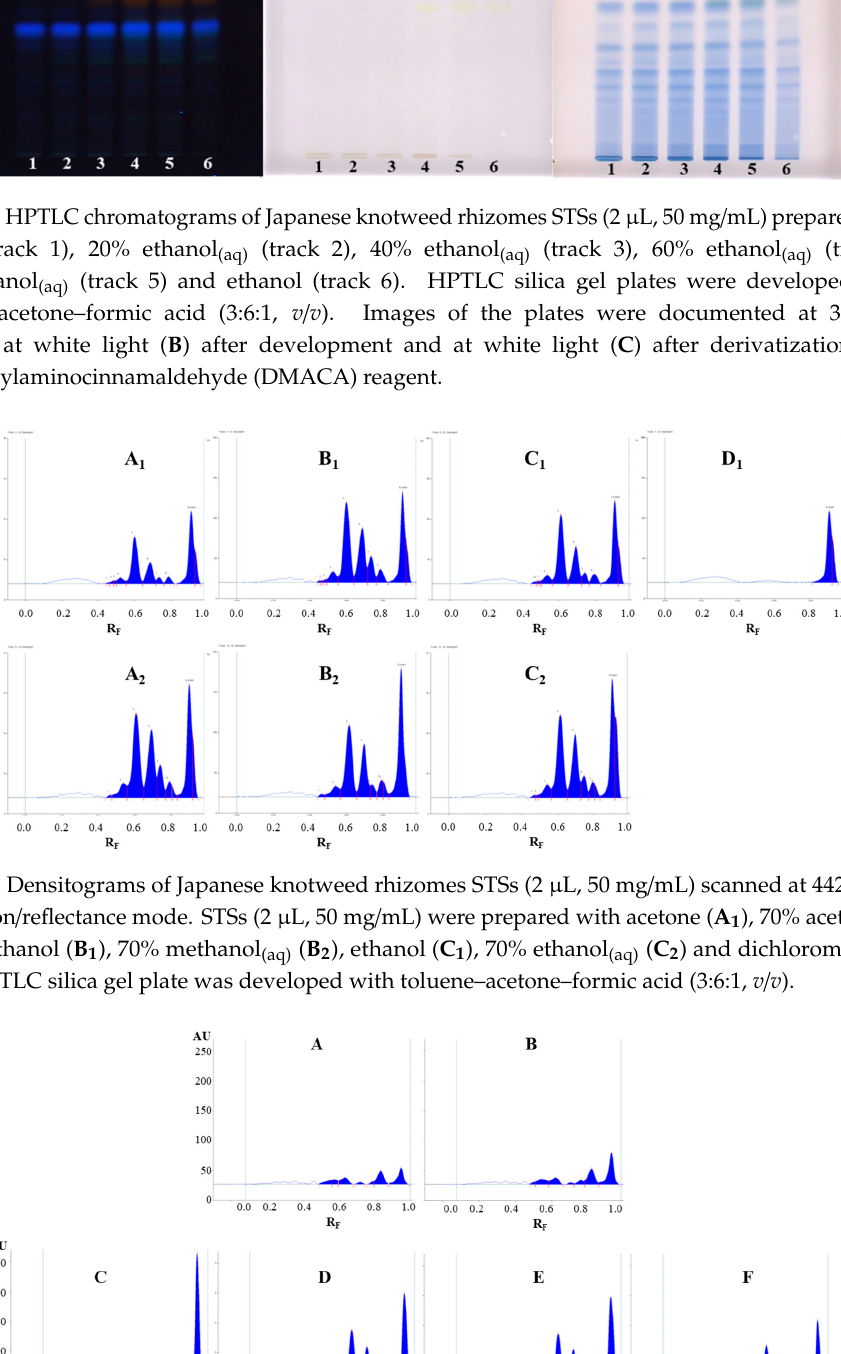
3 of 16 Figure 1. HPTLC chromatograms of physcion (1 μ g; track 1), chrysophanol (1 μ g; track 2), aloe-emodin (1 μ g; track 5), emodin (1 μ g; track 8) and aloin A (1 μ g; track 11) standards and Japanese knotweed rhizomes STSs (2 μ L, 50 mg/mL) prepared with acetone (track 3), methanol (track 4), ethanol (track 6), dichloromethane (track 7), 70% acetone (aq) (track 9), 70% ethanol (aq) (track 10) and 70% methanol (aq) (track 12). HPTLC silica gel plates were developed with toluene–acetone–formic acid (3:6:1, v / v ) and documented after development at 366 nm ( A ) and at white light ( B ). On the second plate were STSs prepared with 20% ethanol (aq) , 40% ethanol (aq) , 60% ethanol (aq) , 80% ethanol (aq) and ethanol (Figure 2). Both plates were developed with the developing solvent toluene–acetone–formic acid (3:6:1, v / v ). As shown in Figure 1 (tracks 1, 2, 5, 8 and 11), all standards were detected at 366 nm and at white light illumination conditions. At 366 nm standards of physcion, chrysophanol, aloe-emodin and emodin were detected as yellow bands at R F values in the range of 0.88–0.93, while standard of aloin A (track 11) was detected as orange-brown band at R F 0.42. At white light, all standards appeared as yellow bands (Figure 1B). At 366 nm, two yellow bands were detected at R F 0.90 and 0.93 in tracks of STSs prepared with ethanol, 70% ethanol (aq) , methanol, 70% methanol (aq) , acetone, 70% acetone (aq) and dichloromethane (Figure 1A, tracks 3, 4, 6, 7, 9, 10 and 12). Similarity between the colors of the band of aloin A standard (Figure 1, track 11) and the bands of STSs prepared with ethanol, 70% ethanol (aq) , methanol, 70% methanol (aq) , acetone and 70% acetone (aq) at R F values 0.60, 0.69 and 0.74 (Figure 1, tracks 3, 4, 6, 9, 10 and 12) was observed. These bands that appear orange-brown at 366 nm (Figure 1A) are yellow at white light (Figure 1B). Two intensive yellow bands at R F s 0.90 and 0.93 were detected at 366 nm and at white light on the second HPTLC plate but only for STSs prepared with 60% ethanol (aq) , 80% ethanol (aq) and ethanol (Figure 2, tracks 4–6). The yellow band at R F 0.90 with comparable intensity was observed also for